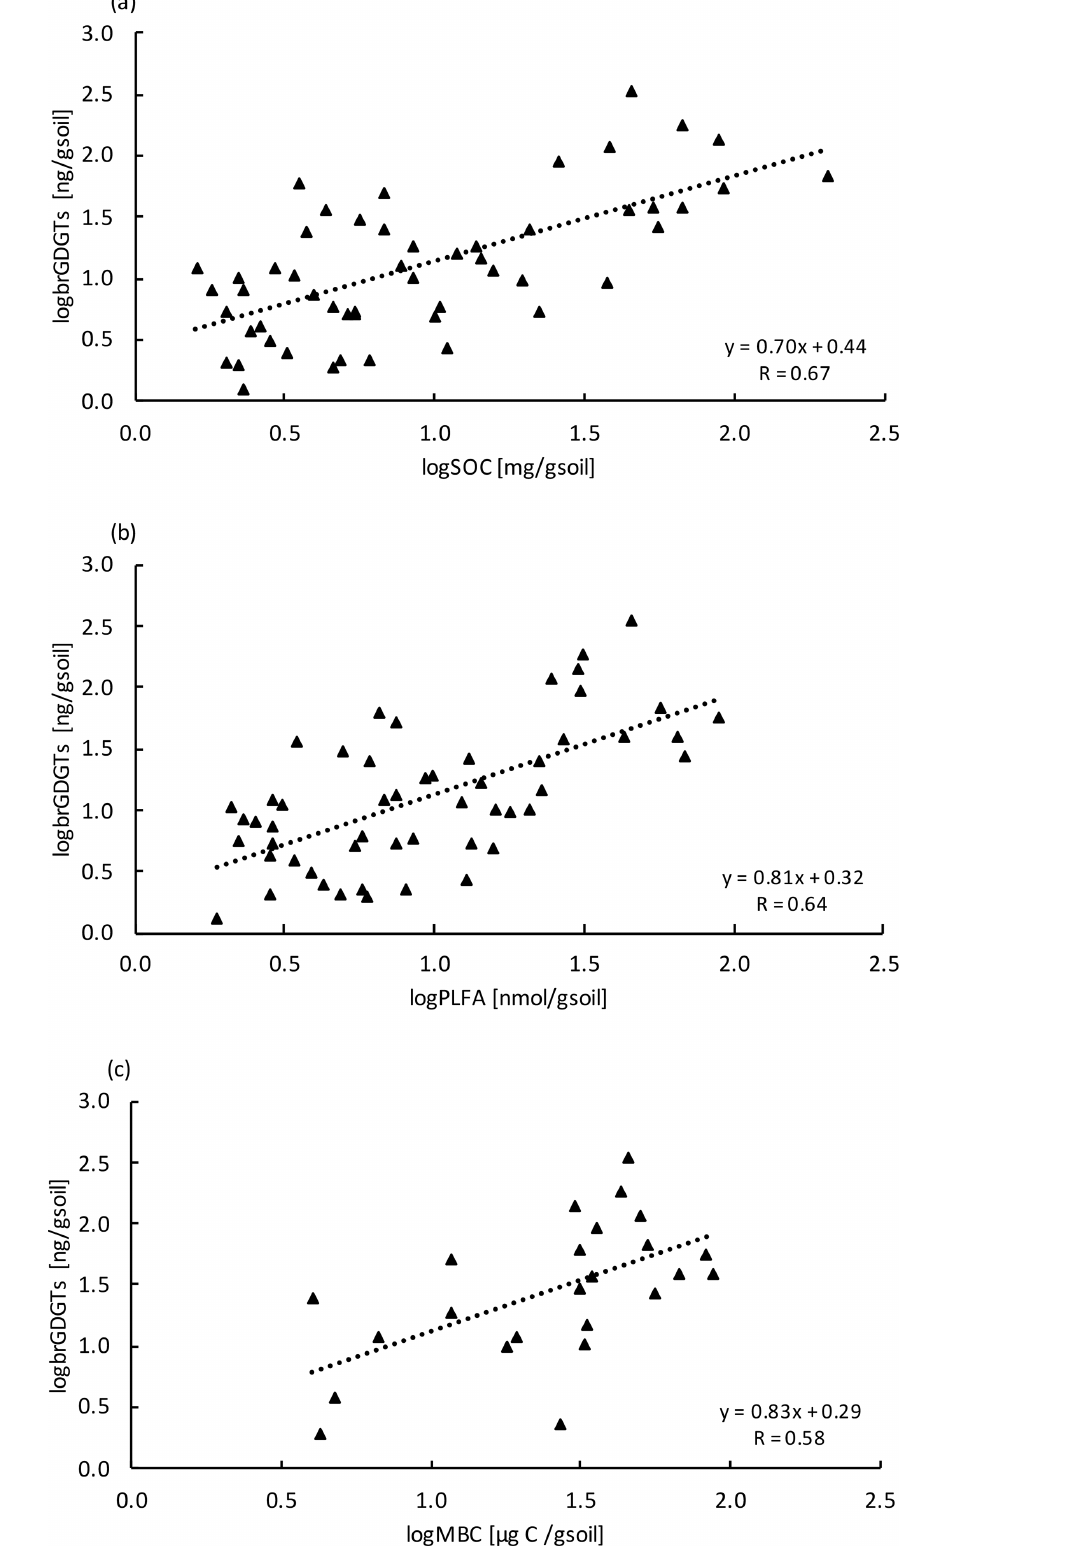
Figure A4. Relationship between (a) brGDGT with SOC ( n = 54), (b) brGDGT with PLFA ( n = 54), and (c) brGDGT with MBC ( n = 24) at all depth increments. Values were log transformed to meet